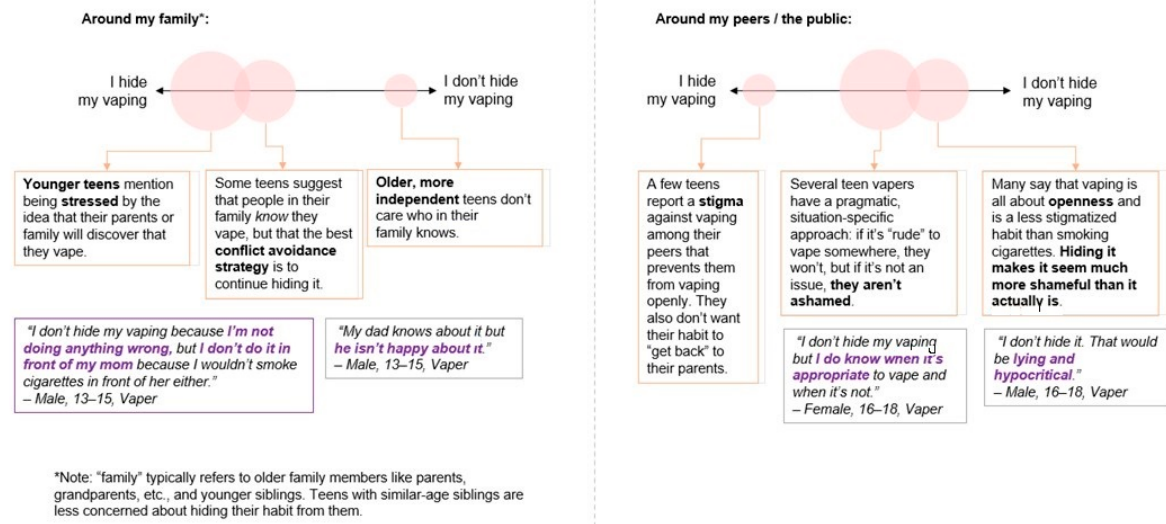
Figure 2. Openness About Vaping. Note: The size of the bubbles corresponds with the proportion of participant comments related to the theme.